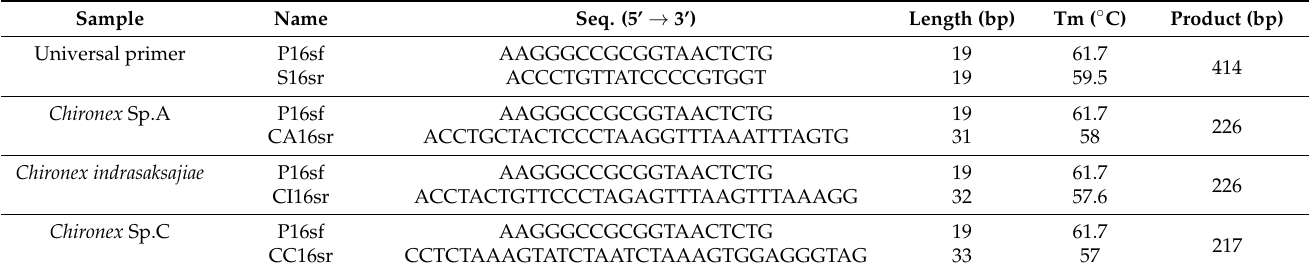
Table 4. List of the COI primers of three Thai Chironex